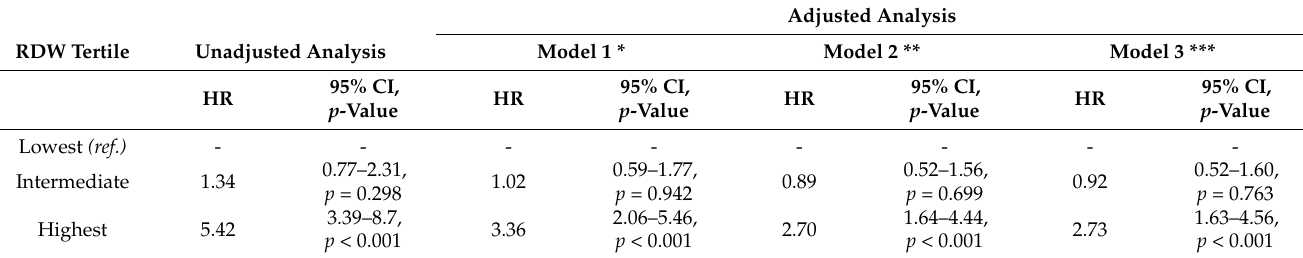
Table 3. Unadjusted and adjusted Cox regression analysis for all-cause